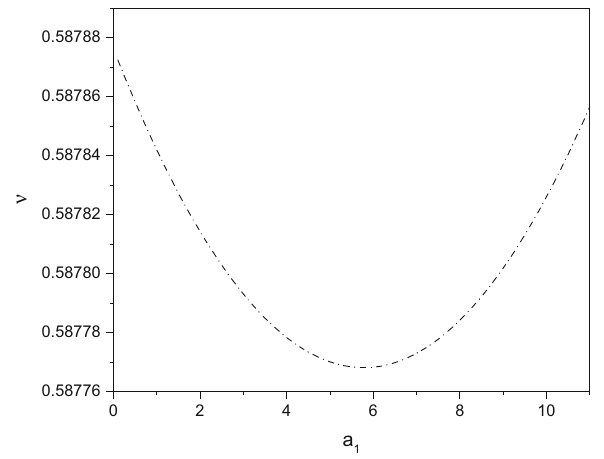
Fig. 1 In this figure, we plot the three dimensional exponent ν of the self-avoiding walks model ( N = 0) approximated by the eight parame- (cid:5) ters approximant 2 5 F 3 ( a 1 , a 2 ,..., a 5 ; b 1 , b 2 , b 3 ;− 3 an arbitrary